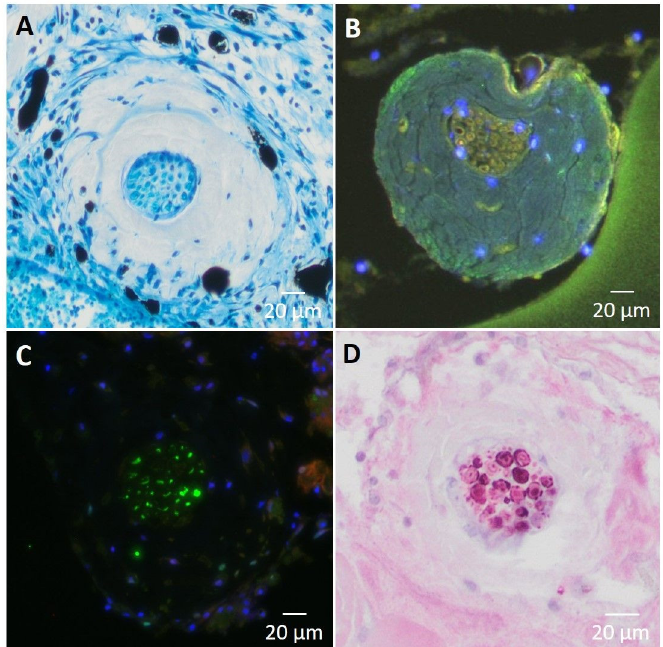
Figure 10. ( A ): Cross section through the motor nerve branch, stained with methylene blue (PCP4). Newly formed vessels filled with India ink show pronounced vascularization in the vicinity of the nerve. ( B ) (PC2) and ( C ) (PCP4): Synaptophysin staining of axon cross-section shows the presence of synaptic vesicle proteins p38 (green). ( D ): S100 immunohistochemistry showing peripheral glial cells (Schwann cells) between the axons of the motor nerve (PCP2).